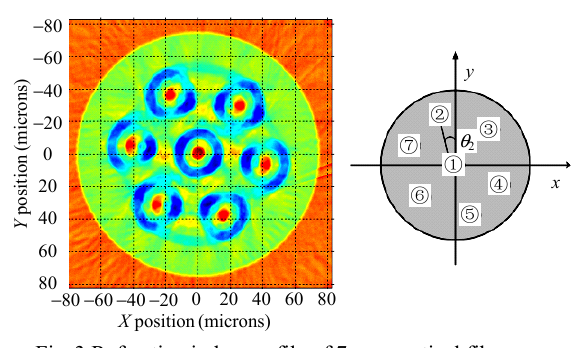
Fig. 3 Refractive index profile of 7-core optical fiber.